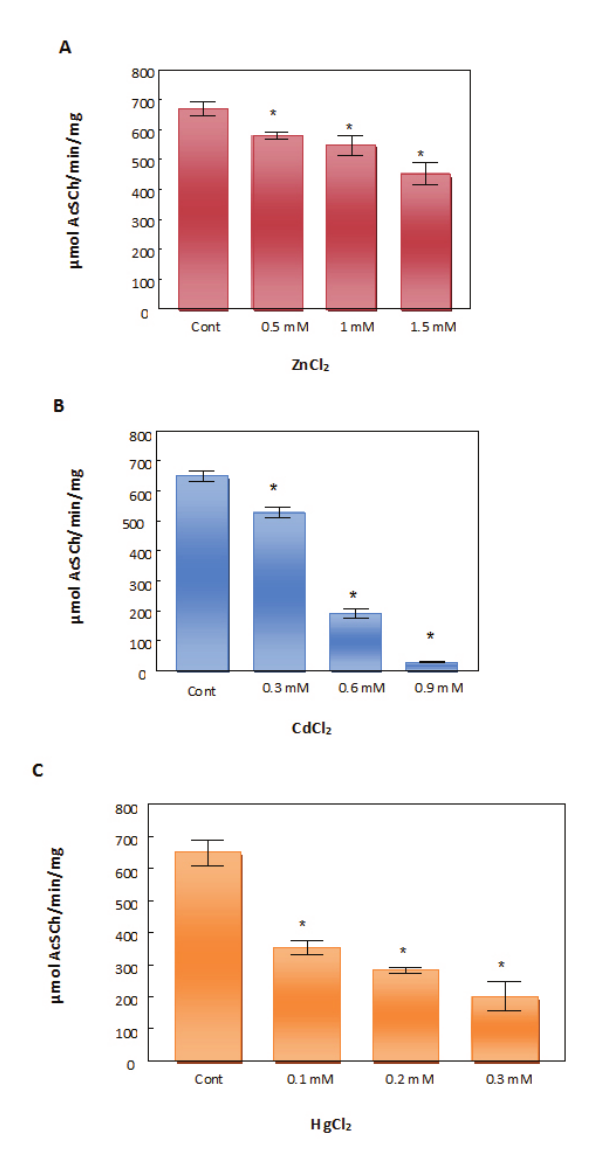
Figure 6. Inhibition of krait ( Bungarus sindanus ) venom AChE by metals. Various concentrations of , ( B ) CdCl , and ( C ) HgCl were incubated ( A ) ZnCl 2 2 2 at 37°C for ten minutes in 10 mM Tris-HCl buffer, pH 8.5. Reactions were started by adding 1 mM acetylcthiocholine (AcSCh) as a substrate. ( A ) p < , ( B ) p < 0.00028 for CdCl , and ( C ) p 0.029 for ZnCl 2 2 compared to control. Results < 0.000128 for HgCl 2 represent the mean of four different experiments performed in